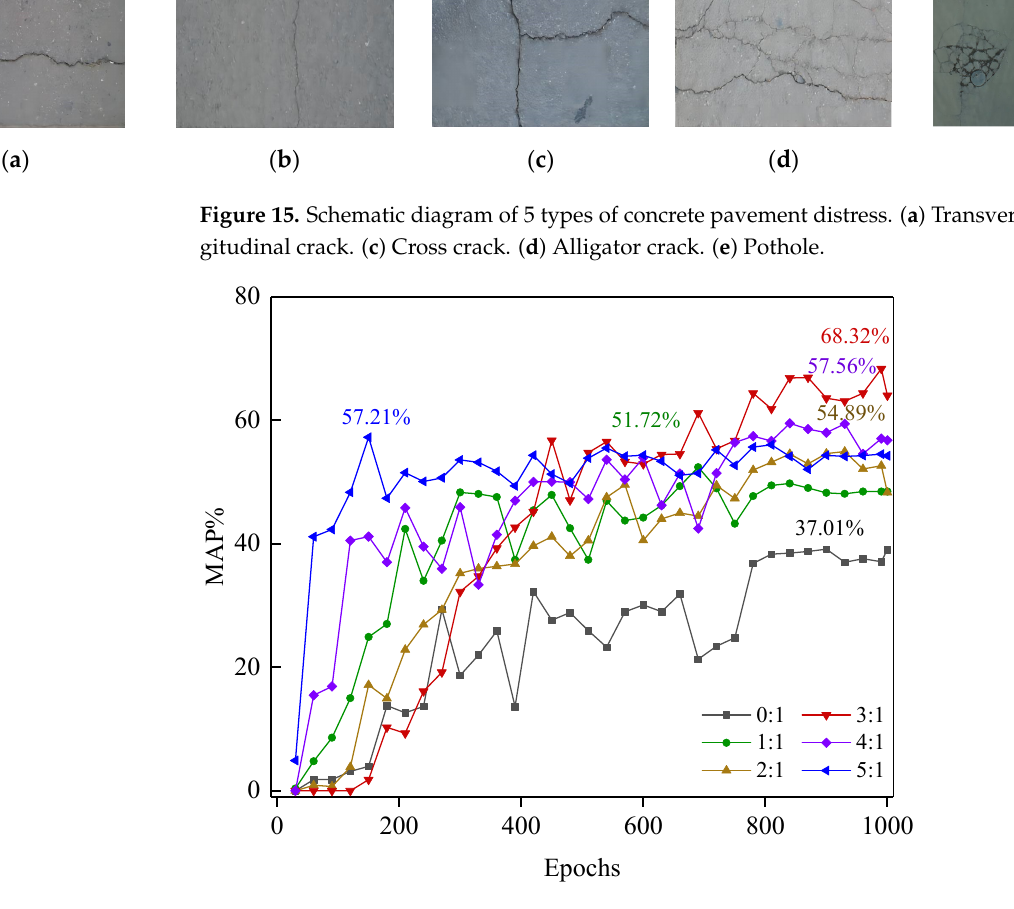
Figure 16. MAP for the integrated dataset of six virtual-to-real ratios on concrete pavement.